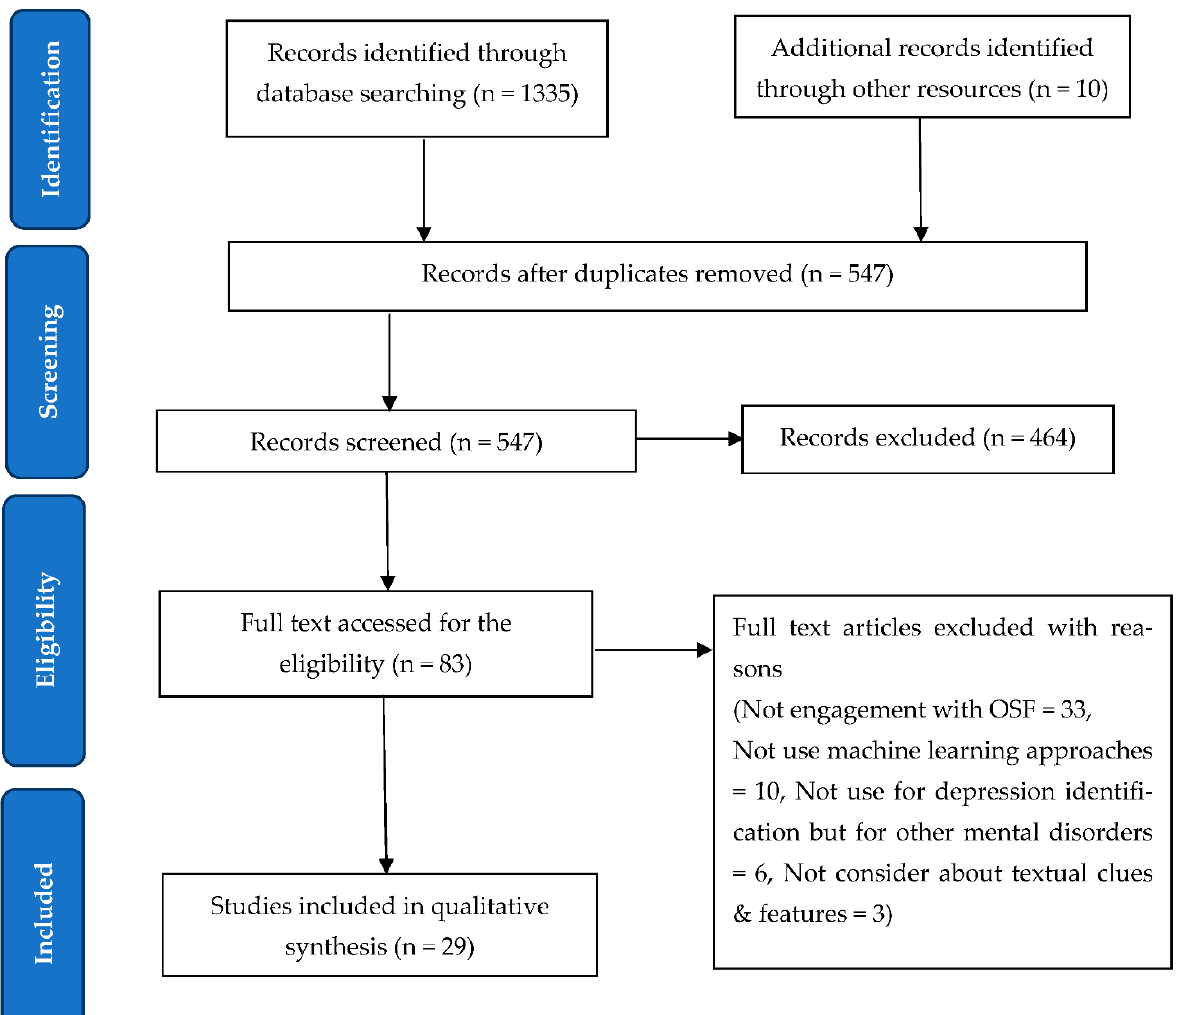
Figure 1. PRISMA Flowchart Diagram.